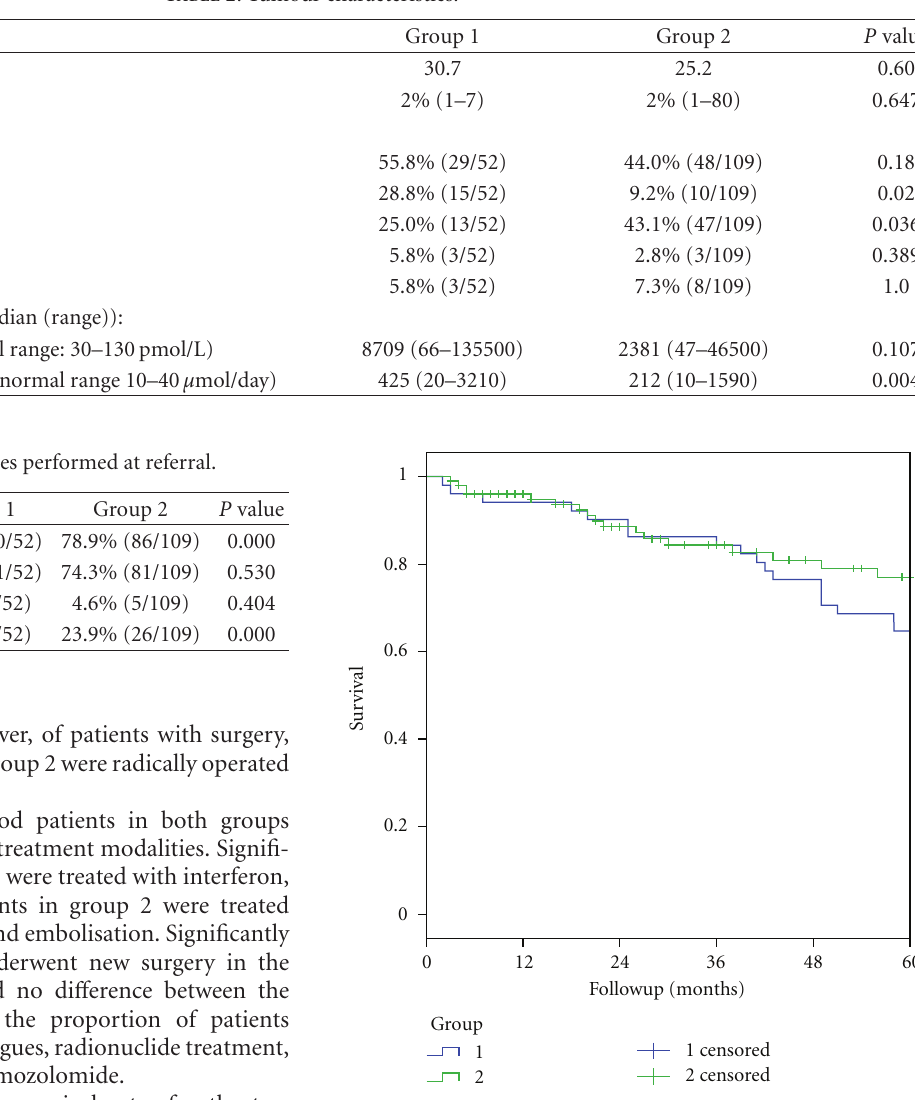
Figure 1: 5-year survival rate for patients seen in the